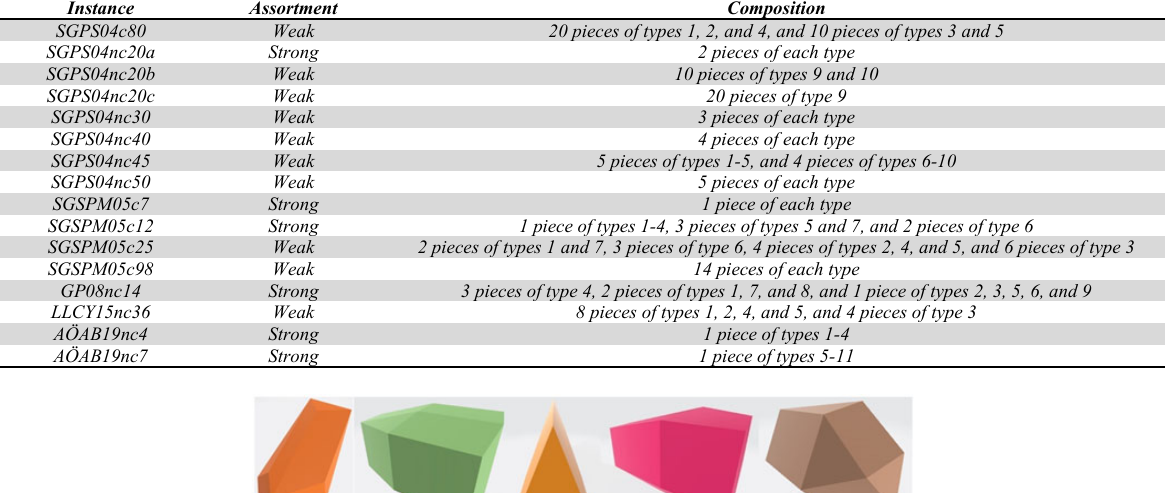
Fig. 7. Convex Pieces (1 to 5 from left to right) of the data set SGPS04 from Stoyan et al. (2004)